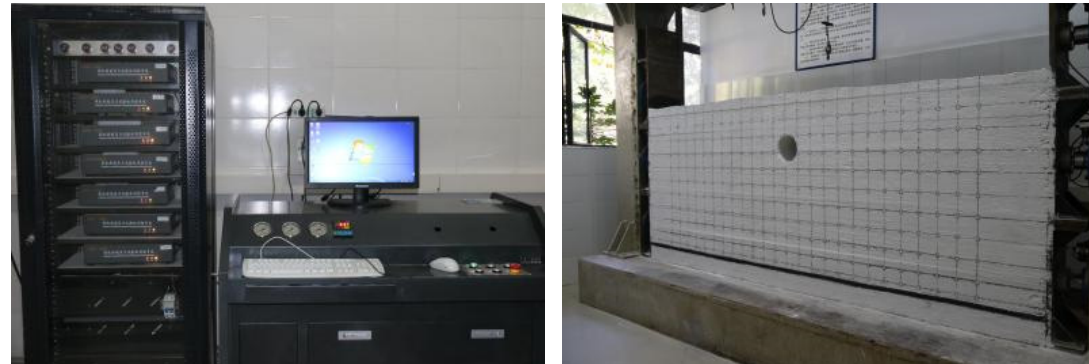
Figure 3. Model laying and monitoring line layout.